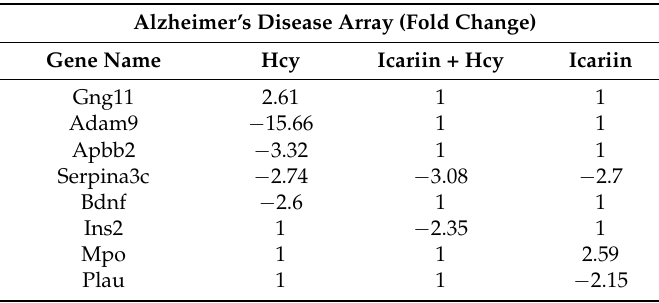
Table 1. RT 2 Profiler PCR Array Gene Expression